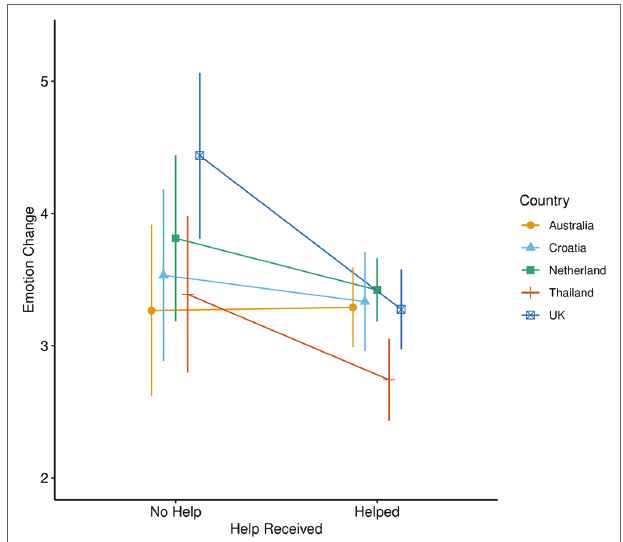
FIGURE 2 | Plot of emotional change ratings whether help was provided when crying in a social context compared by country. Emotion change scores range from 1 = much better to 7 = much